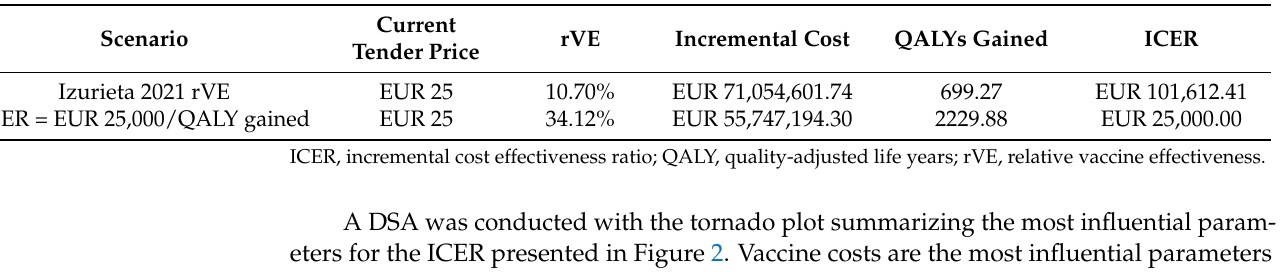
Table 3. Analyses of QIVr compared to adjuvanted influenza vaccine in adults aged ≥ 65